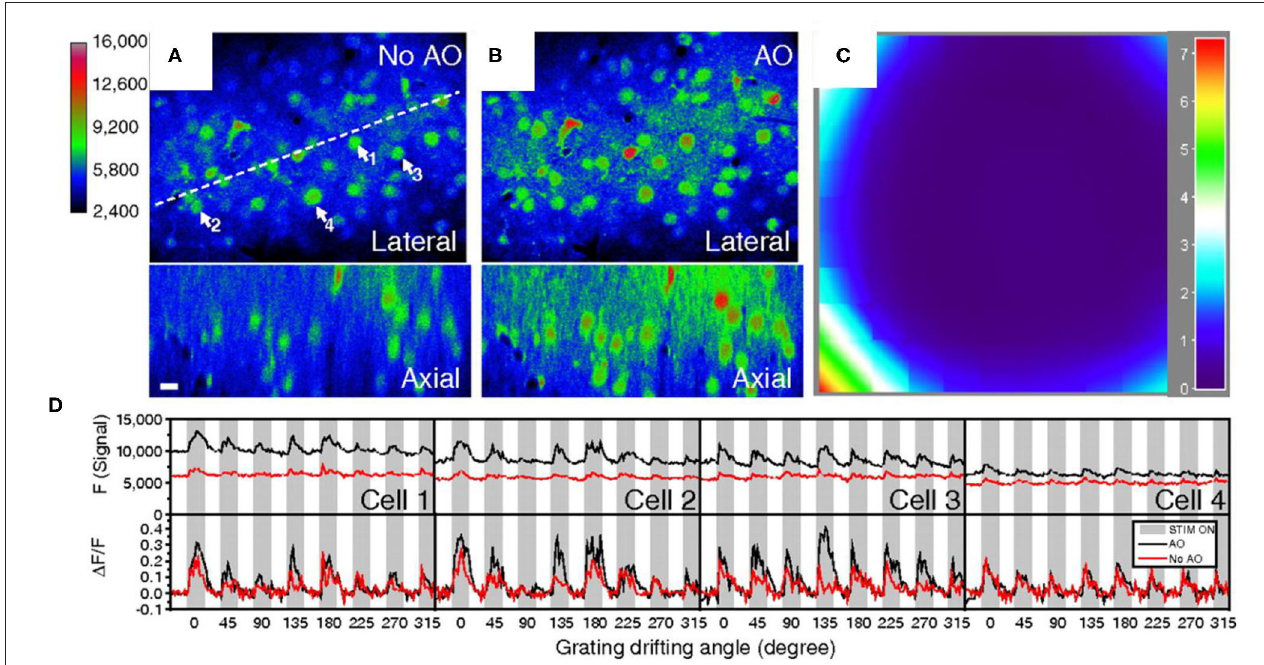
FIGURE 1 | Adaptive optics (AO) based image correction in vivo. (A) Two photon fluorescence lateral and axial images of OGB-1 AM labeled neurons at 155 µ m below the brain surface in absence of AO correction. (B) With AO correction. (C) Shows the measured aberration of excitation wavelength. (D) Fluorescence signal (black) and its percentage change (red) for four cells indicated in Figure (A) without and with AO correction. Time periods are denoted wit gray bars. Black-and-white gratings drift in eight different directions, from left to right, 0, 45, 90, 135, 180, 225, 270, and 315 ◦ . This image is adapted with permission from [27].